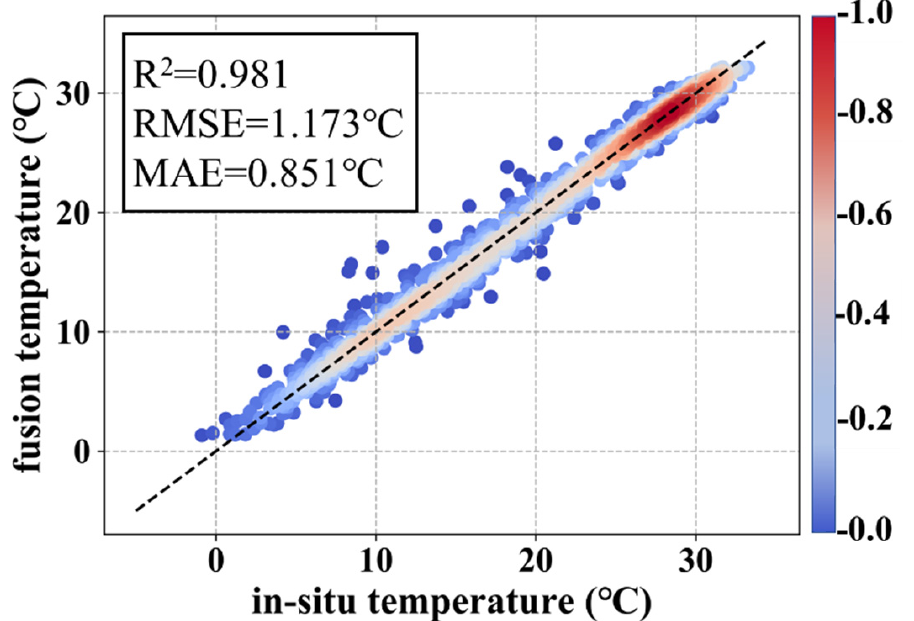
Figure 15. The density scatter plots of the 3H air temperature for the Austin, Texas area for the cross-validation results.